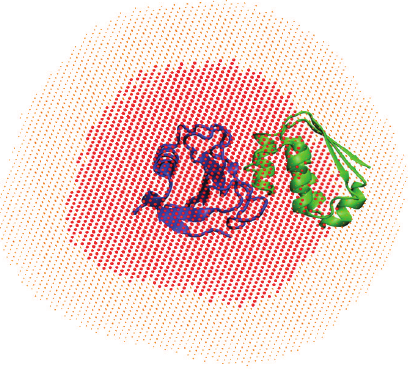
Figure 2: The shell-based grid force field of protein I of 1AY7. Protein I is shown in blue and protein II in green. Each point represents a force field grid with a 3 ˚A resolution. Accordingly, for the inner shell (in red) one point corresponds to 6 grids with 0.5 ˚A resolution; for the outer shell (in orange) one point corresponds to 4 grids with 0.75 ˚A resolution.